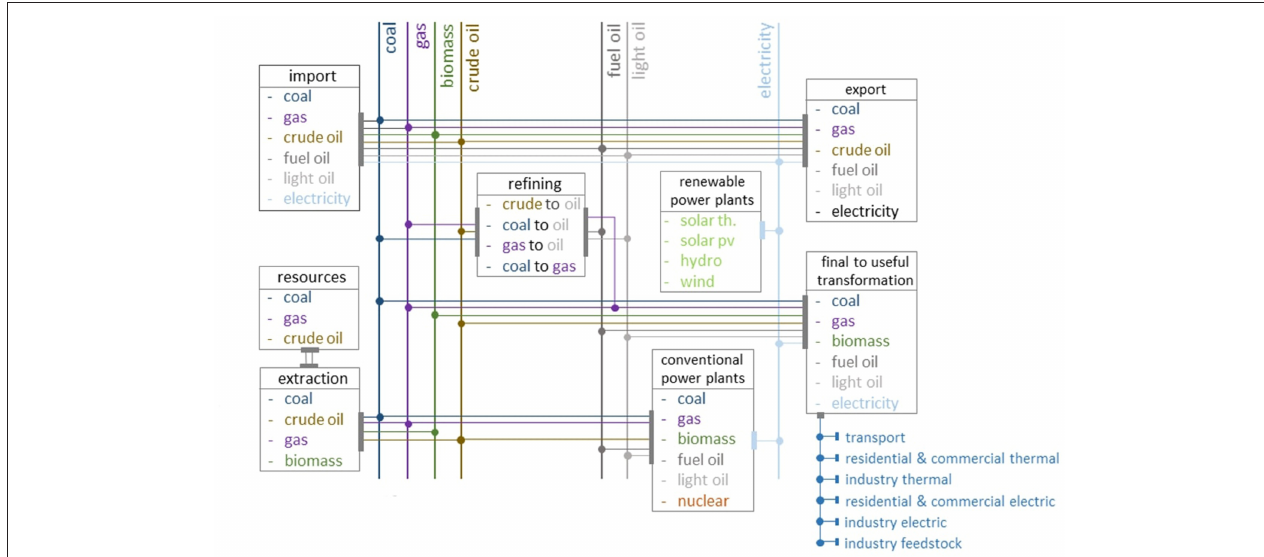
FIGURE 2 | Stylized model work flow chart showing the commodities and technology groups described by the model MESSAGEix-South Africa.